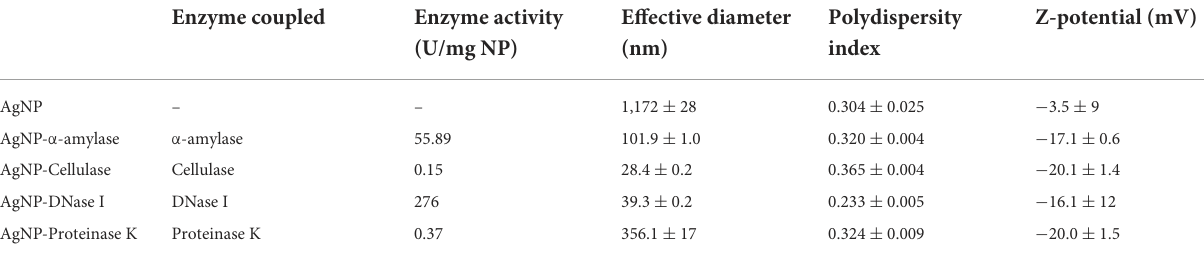
TABLE 1 Composition, encapsulation efficiency, and properties of drug-loaded nanoparticles. Enzyme